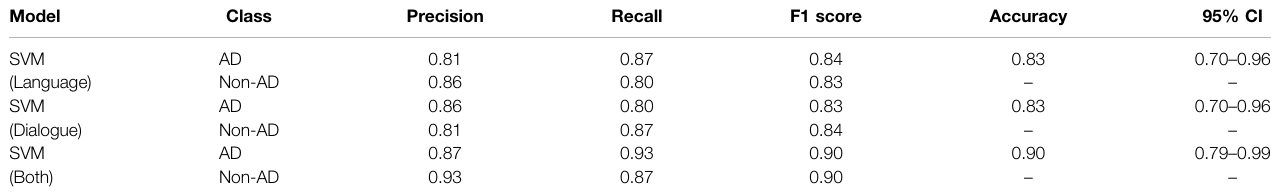
TABLE 9 | Results of AD classi fi cation task with SVM classi fi ers with different feature sets, using LOOCV, with 95% con fi dence intervals (CI). Model